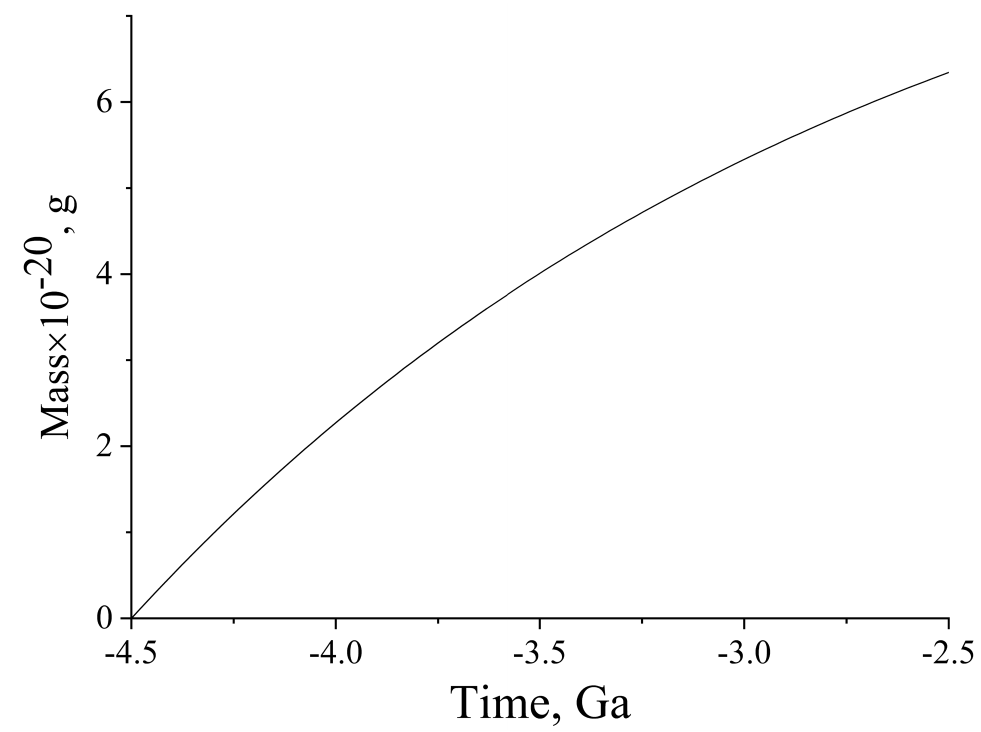
Figure 5. Time dependence of oxygen formation upon radiolysis of sea water.